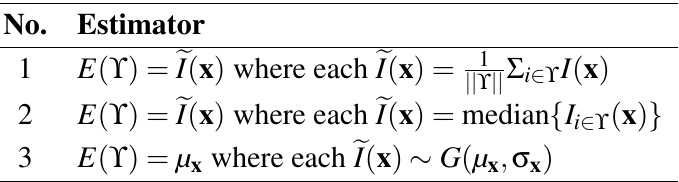
Table 1. List of some common function estimator E ( ϒ ) for pixel